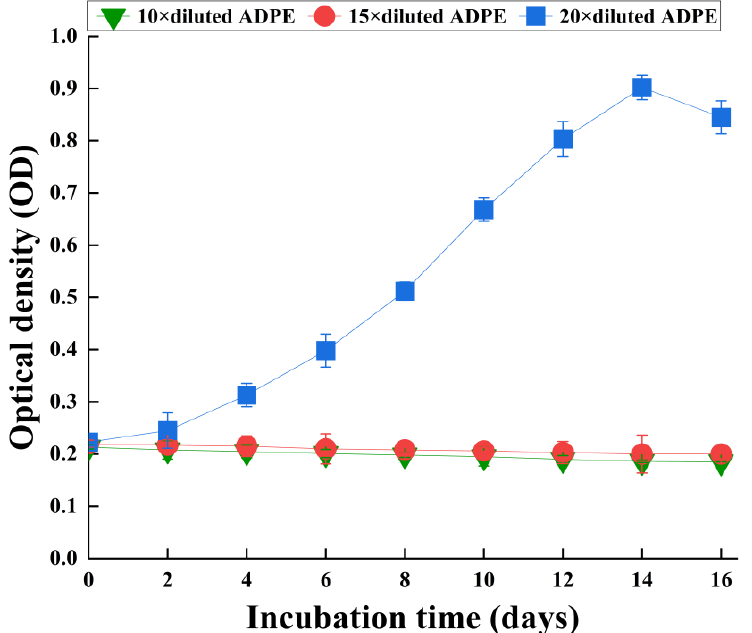
Figure 2. Growth curves of NCU-39 in different diluted anaerobic digestion piggery effluents (ADPEs) (10-fold (10×), 15×, and 20× dilution). Error bars represent standard deviations ( n = 3).